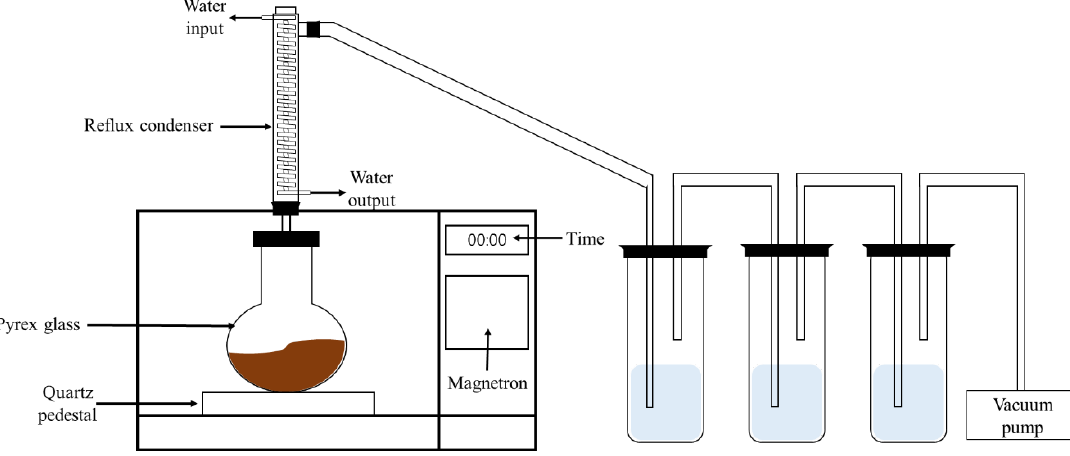
Figure 1. Schematic of laboratory-scale microwave apparatus.